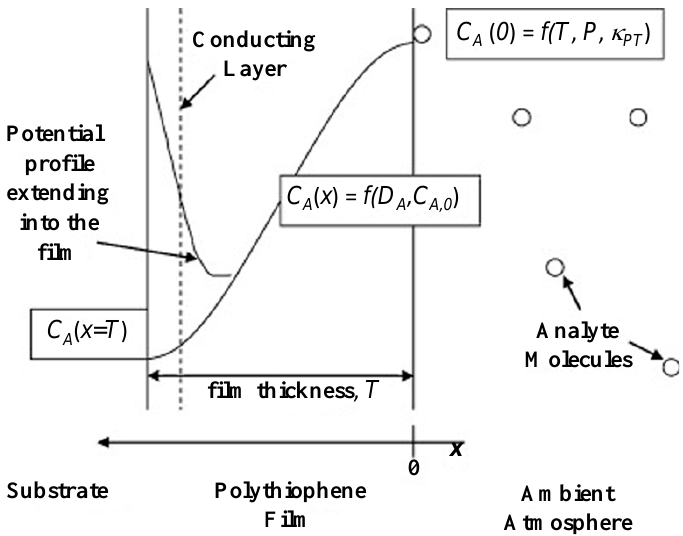
Figure 3. Conceptual framework for physical discrimination. Partial analyte molecules in the ambient atmosphere will adsorb onto the surface of the polythiophene film at x = 0 and diffuse into the film toward the substrate, eventually interacting with the semiconductor layer at the dielectric–semiconductor interface. Reprinted with permission from Ref. [27]. Copyright (2010) Elsevier.